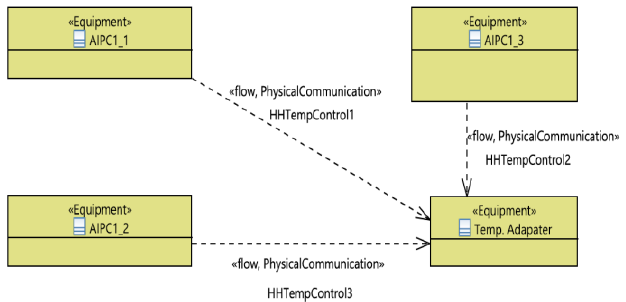
Fig. 5- Communication links between the equipment implementing different